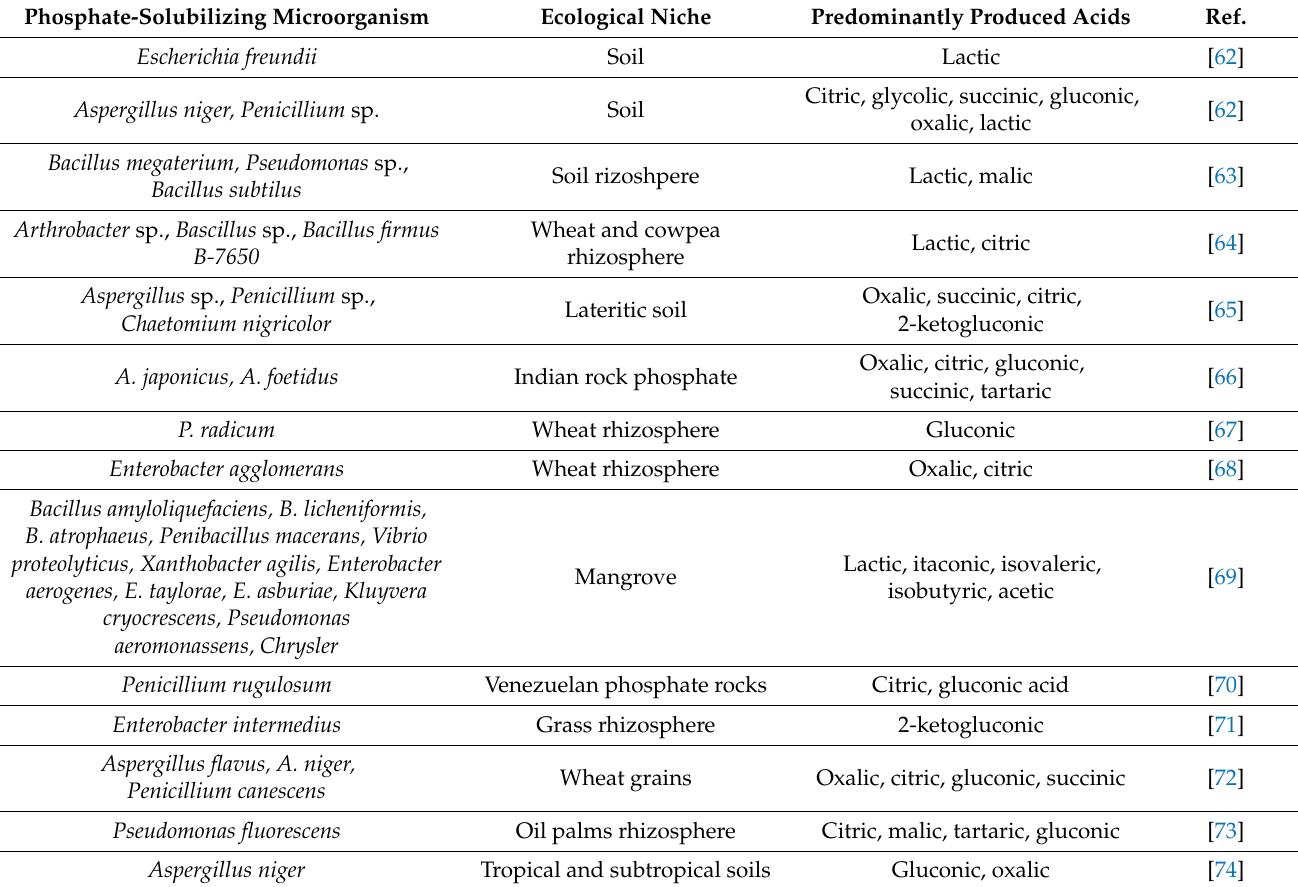
Table 2. Important phosphate-solubilizing microorganisms, their ecological niches, and organic acids